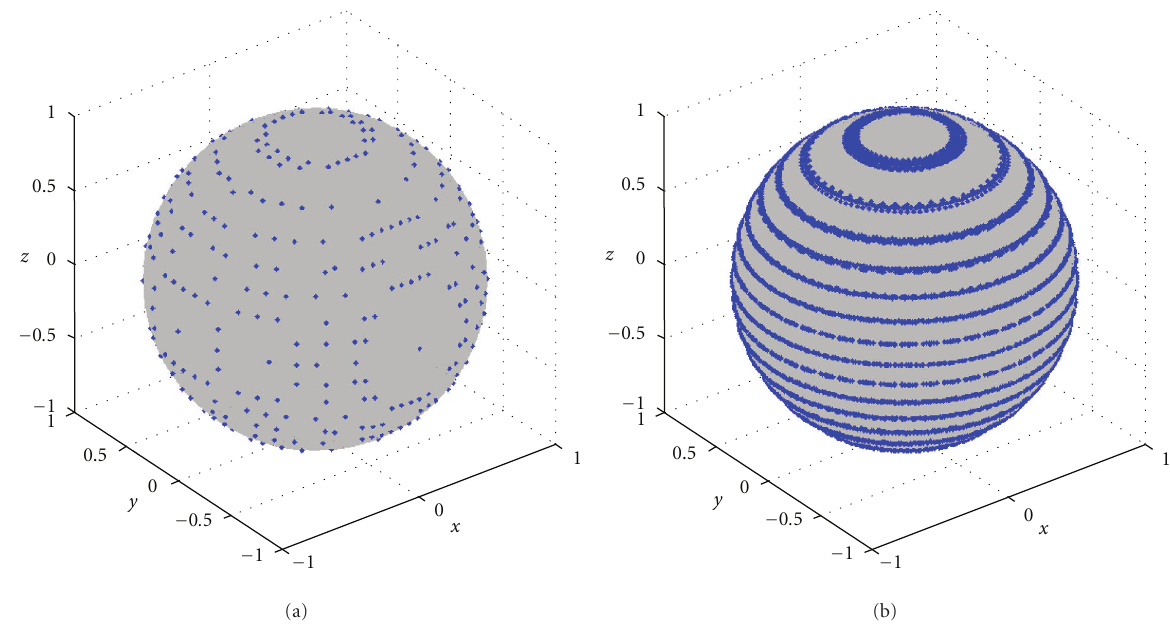
Figure 10: Plane-wave directions of incidence for modes in a 50MHz band around 750 MHz in a large chamber with dimensions D x = 3m, D . 5m. (a) Without turntable. (b) With turntable rotating around a z -directed axis. Without the turntable, the maximum D y = 2m, and z = 1 distance between directions of incidence is 22 ◦ and the average distance is 6 ◦